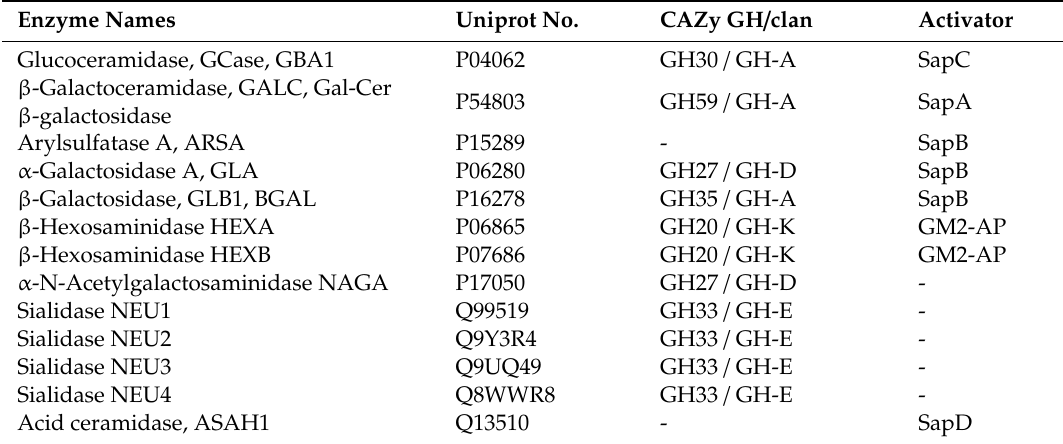
Table 3. Human hydrolases acting on glycosphingolipids and